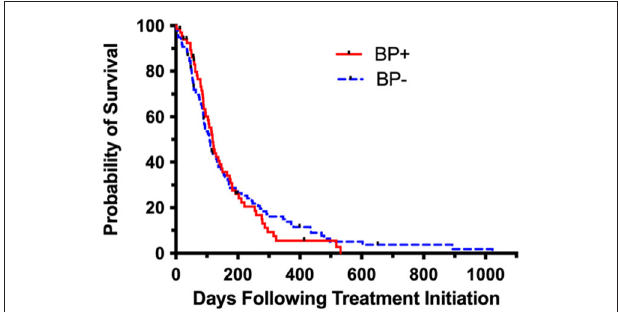
FIGURE 1 | Kaplan-Meier survival curve analysis of BP + (bisphosphonate) vs. BP– (no bisphosphonate) dogs. The median survival time of BP + dogs was not significantly different than the median survival time for BP– dogs (119 vs. 109 days and p = 0.758).